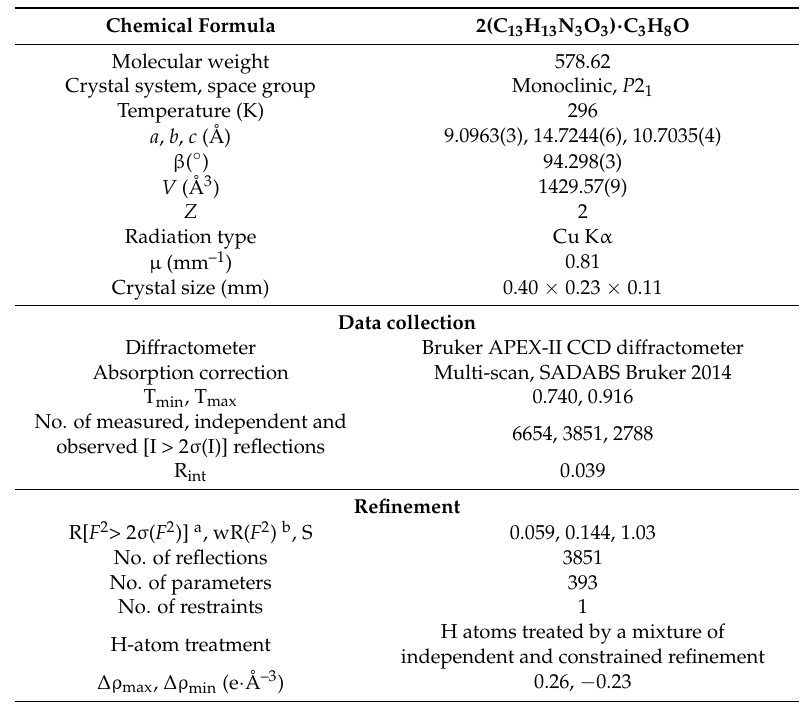
Table 7. The crystallographic data and refinement